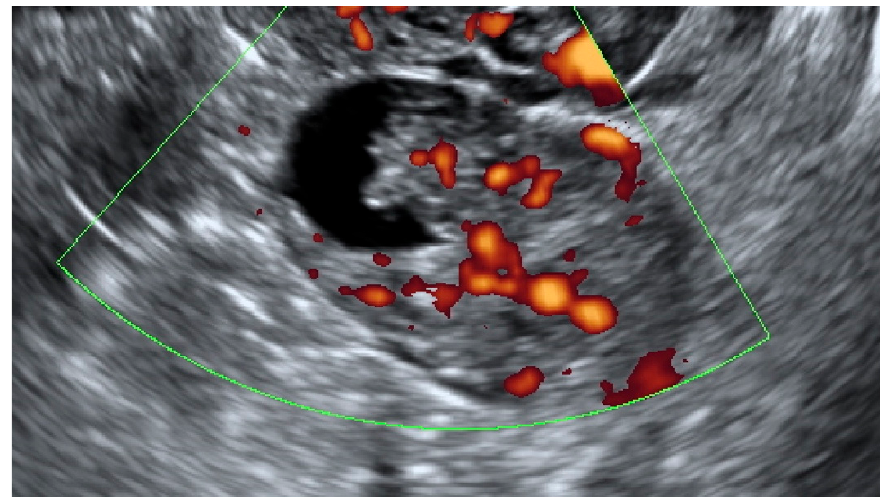
7 of 17 Figure 4. ( A ) Grayscale imaging of two perpendicular sections of a small, oval ovarian lesion resem- bling “ground-glass” echogenicity. ( B ) Central vascularization (color score, 4) seen in 3 perpendic-